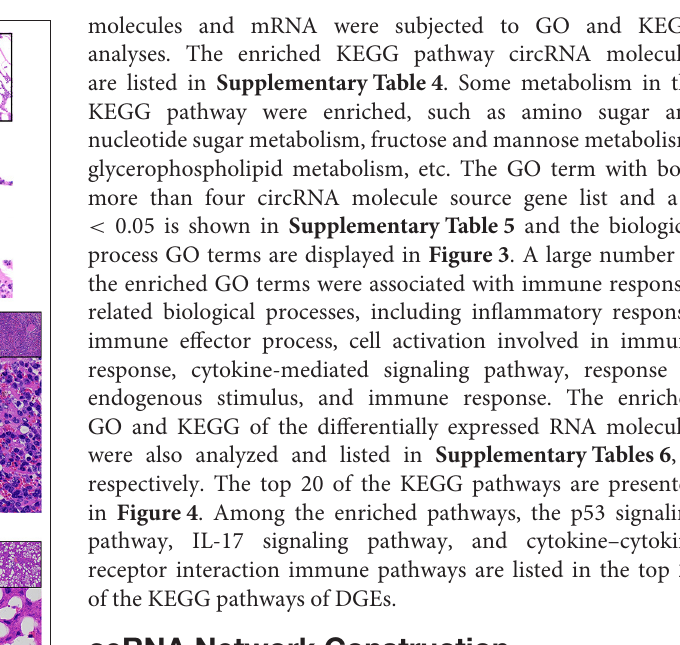
downregulated in the Pm group compared with the CK group ( Supplementary Figures 2A,D